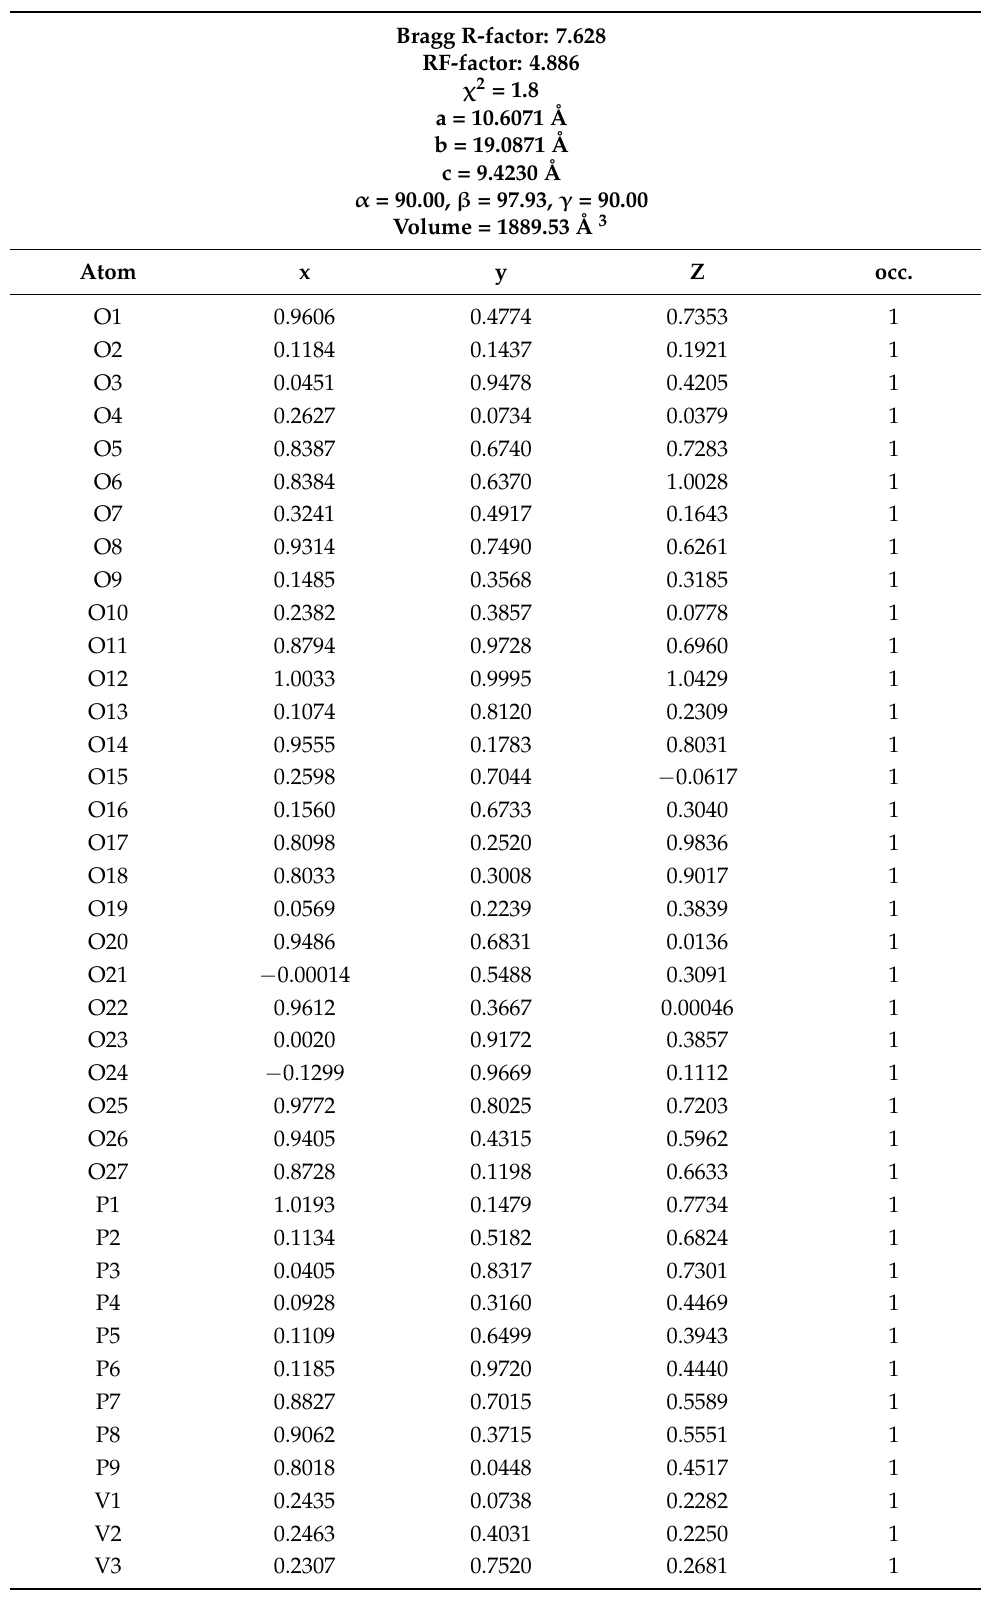
Table 3. Rietveld structural refinement